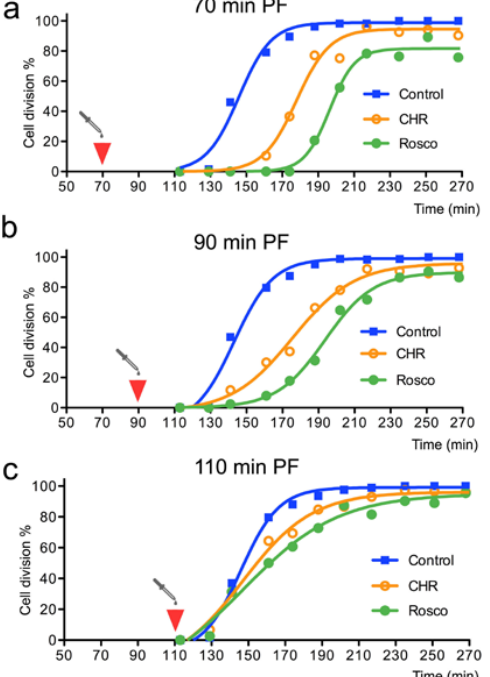
Figure 6. CHR-6494 and Roscovitine administration delays cell division and impacts cleavage rates in S. granularis embryos. ( a – c ) Plots represent the proportion of embryos that have completed their first cleavage at di ff erent time points (minutes PF). Final concentrations for CHR-6494 and Roscovitine were respectively 0.5 µ M and 10 µ M. For each experimental condition, a culture sample was collected 20 min after drug addition and processed for T3H3ph immunostaining (see Figure 7). ( a ) Drug addition at 70 min PF (red arrowhead) caused a general delay in the cleavage onset. ( b ) Drug addition at 90 min PF delayed cleavage onset and perturbed culture synchronicity. ( c ) No delay in cleavage onset was observed, but culture synchronicity was still perturbed in embryos treated at 110 min PF.